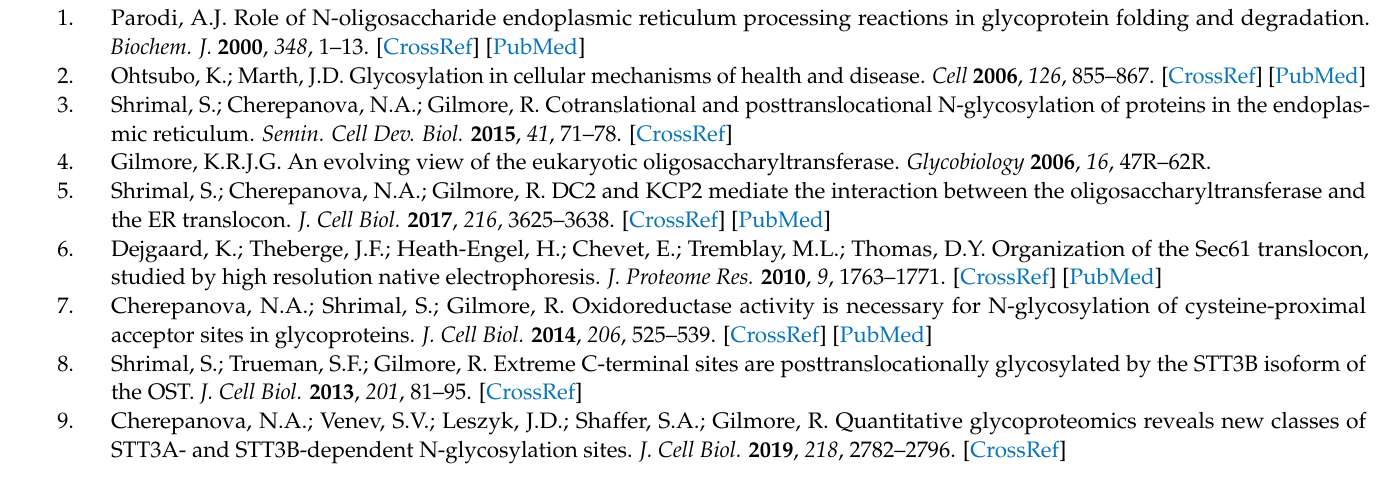
Figure S2: Annotated mass spectrum of hyperglycosylated glycopeptides of ENPL.; Table S1: Iden- tified proteins in WT and KO cells; Table S2: Identified glycoproteins in WT and KO cells; Table S3: DEPs, DEGPs and correlated GO, KEGG results; Table S4: Identified IGPs in WT and KO cells; Table S5: STT3A- and STT3B-dependent glycosites; Table S6: Hyperglycosylated glycopeptides in KO